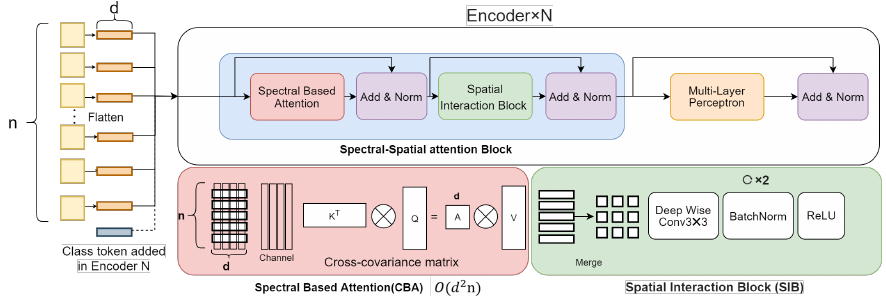
Figure 3. The structure of the proposed spectral–spatial attention vision transformer